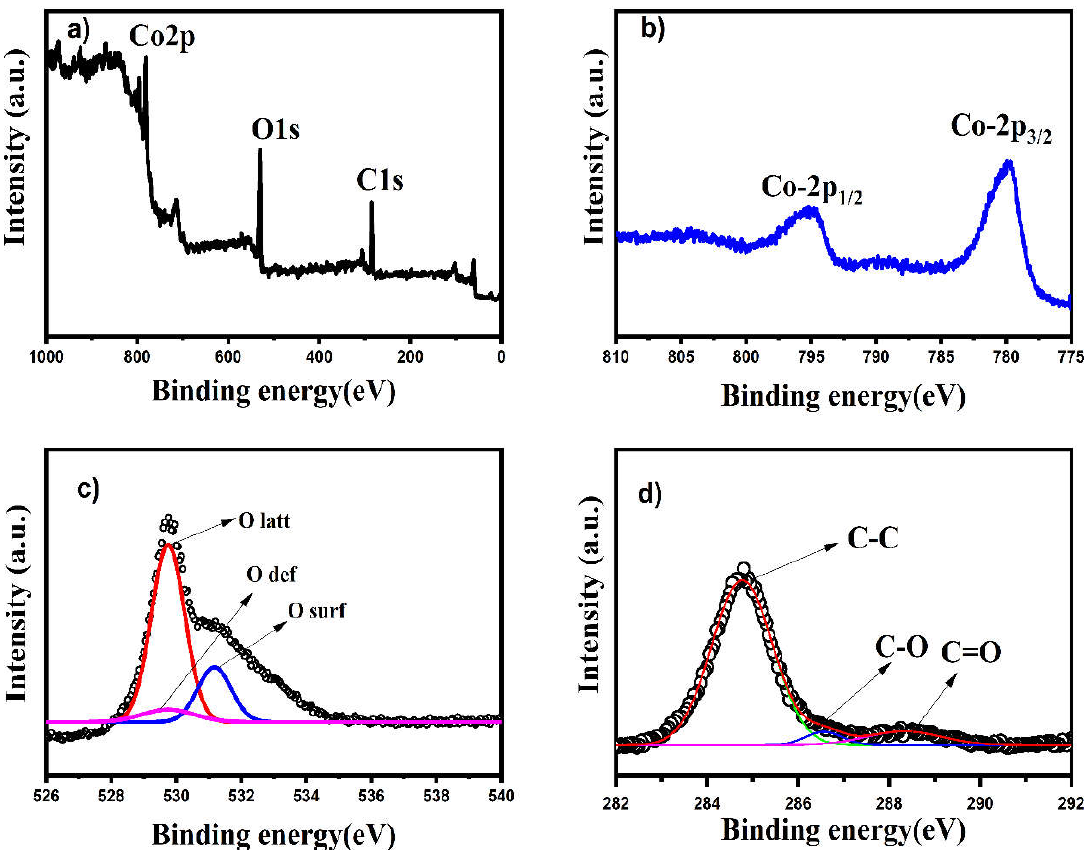
Figure 6. XPS of Co 3 O 4 nanoparticles wide ( a ), cobalt ( b ), oxygen ( c ) and carbon (d) spectrum.